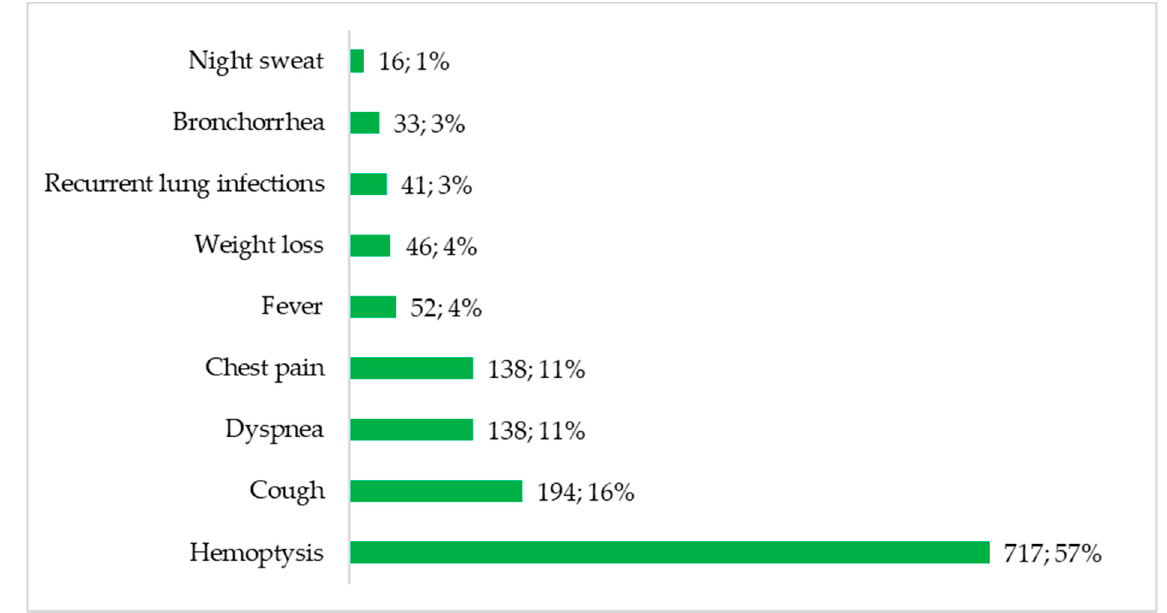
Figure 4. Presenting complaints of patients with CPA in Africa.